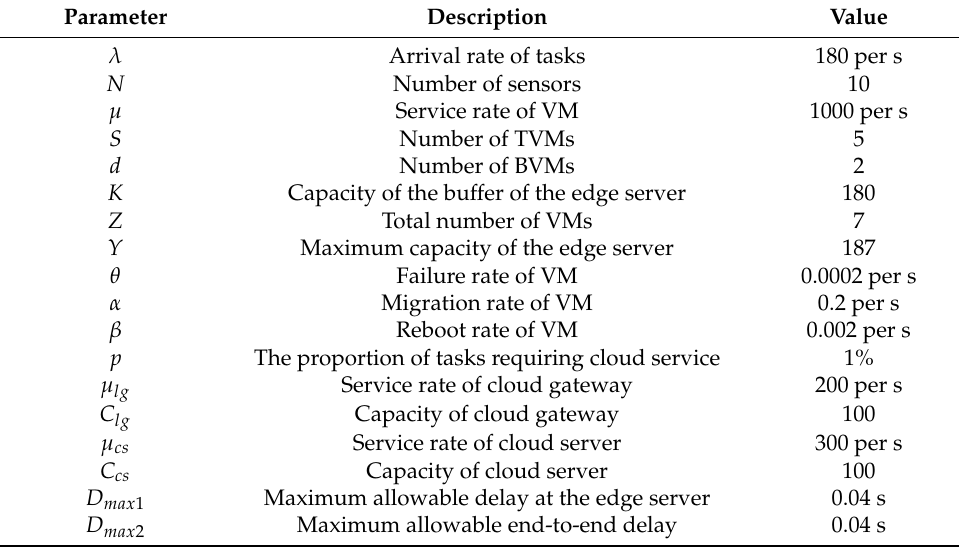
Table 3. Inputting parameters of simulation